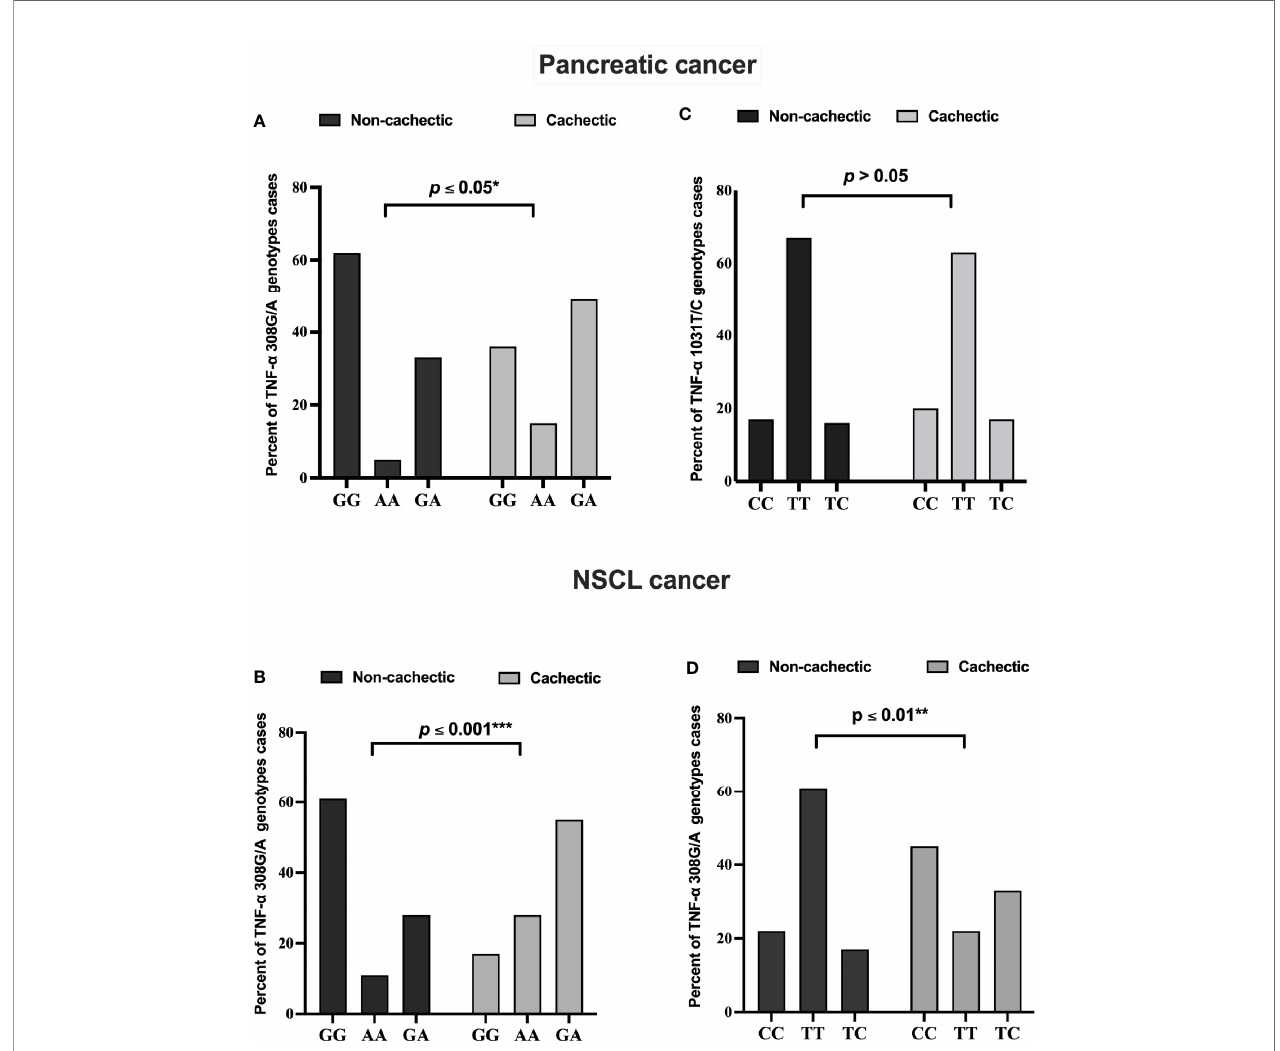
FIGURE 2 | Frequencies of TNF- a 308 G/A genotypes among (A) pancreatic and (B) NSCL cancer patients and TNF- a 1031 T/C genotypes among (C) pancreatic and (D) NSCL cancer patients. Comparison between all genotypes was performed by chi-square test at *p ≤ 0.05. *Signi fi cant difference at p ≤ 0.05. **Signi fi cant difference at p ≤ 0.01 and *** at p ≤ 0.001. NSCL, non-small cell